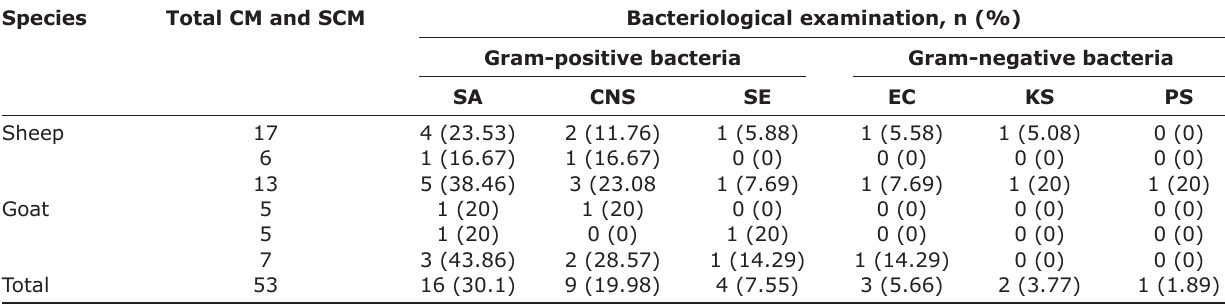
Table-2: Bacteriological examination of sheep and goat milk samples with clinical and subclinical mastitis. Species